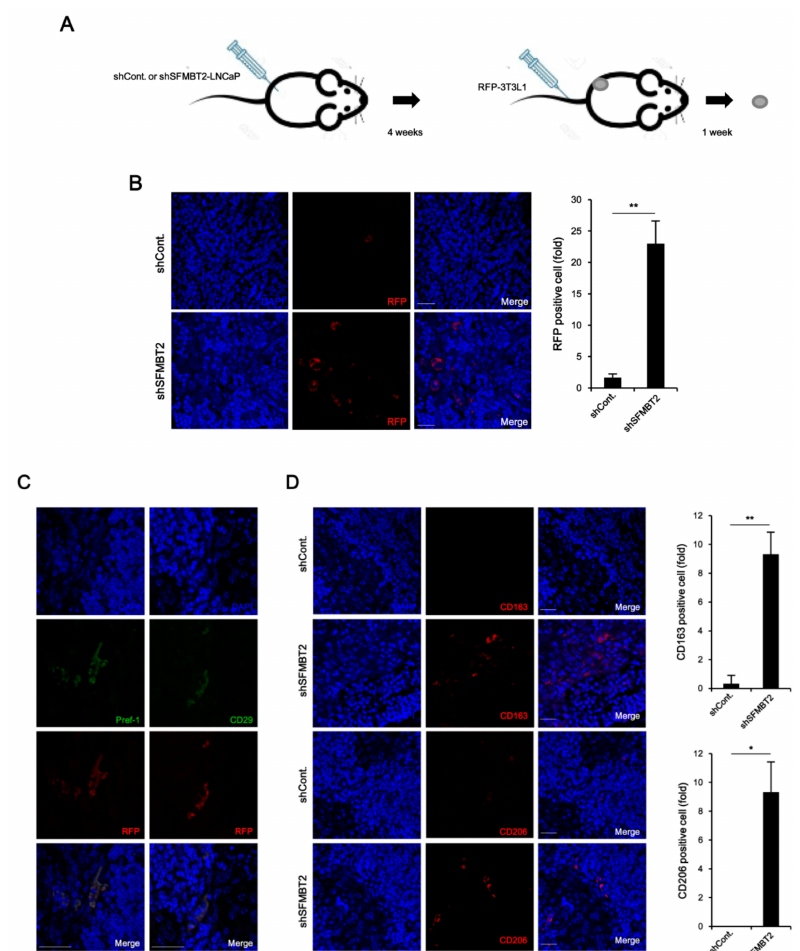
Figure 4. SFMBT2 knockdown LNCaP cells induce the infiltration of preadipocytes and TAMs in the xenograft model. ( A ) Schematic diagram of the xenograft experiment. LNCaP cells stably transfected with control (shCont) or SFMBT2 shRNA (shSFMBT2) were implanted subcutaneously into the flank of nude mice. After 4 weeks, stably RFP-expressing 3T3-L1 cells were injected into the tail vein of the same mouse. One week later, the tumor was harvested, fixed, sectioned, and immunostained with anti-RFP, anti-Pref-1, and anti-CD29 antibodies. ( B ) Increased number of infiltrated RFP-expressing 3T3-L1 preadipocytes in tumors. Representative images are shown. Nuclei were identified using DAPI staining. Scale bar, 25 µ m. RFP positive cells were counted. ( C ) RFP expressing cells are Pref-1 and CD29 positive in tumors. Representative images are shown. Scale bar, 25 µ m. ( D ) Increased number of infiltrated TAMs immunostained with anti-CD163 and anti-CD206 antibodies in tumors. Representative images are shown. Nuclei were identified using DAPI staining. Scale bar, 25 µ m. CD163 or CD206 positive cells were counted. All data represent mean ± S.E.M. Significance values were * p ≤ 0.05 and ** p ≤